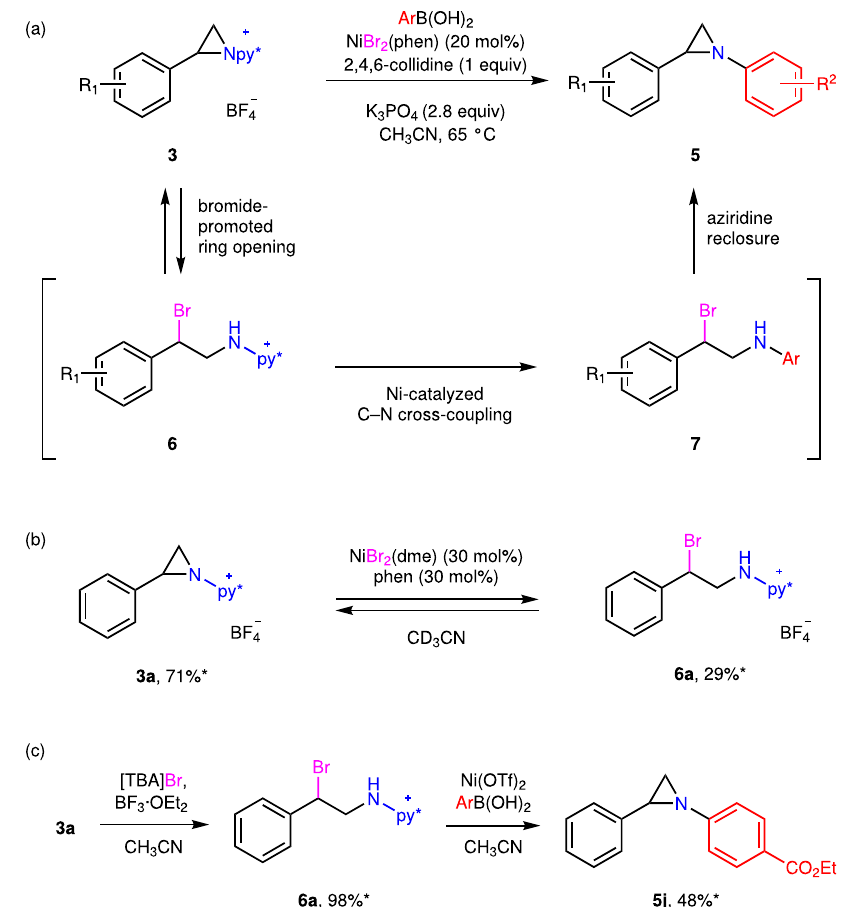
Fig. 5 Summary of available mechanistic data for the cross-coupling of 3a. a Reversible halide-promoted aziridine opening, cross coupling, and aziridine reclosure are proposed to mediate C – N cross coupling of N -pyridinium aziridines. Consistent with this mechanism. b NiBr 2 reacts with N -pyridinium aziridine 3a to generate ring-opened 6a and c exposure of ring-opened 6a to Ni(OTf) 2 or Ni(BF 4 ) 2 affords arylated aziridine 5j . *Yields determined by 1 H NMR